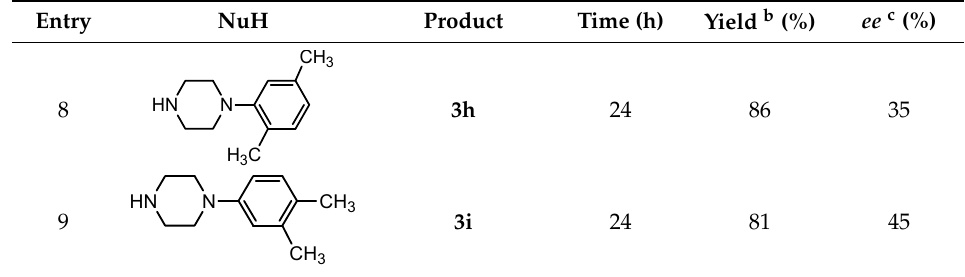
Table 4. Iridium-catalyzed asymmetric ring-opening of oxabenzonorbornadiene 1a with N -substituted piperazines a . Entry